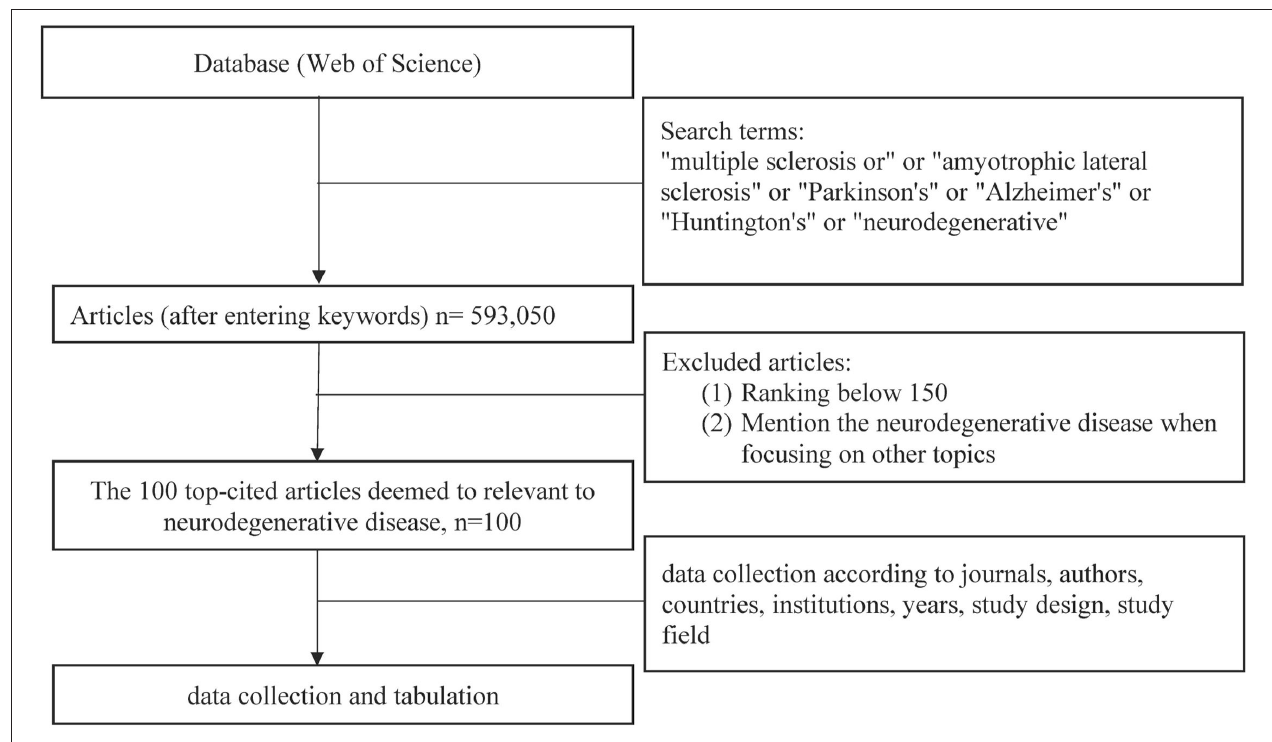
FIGURE 1 | Flowchart of the methodology used in this